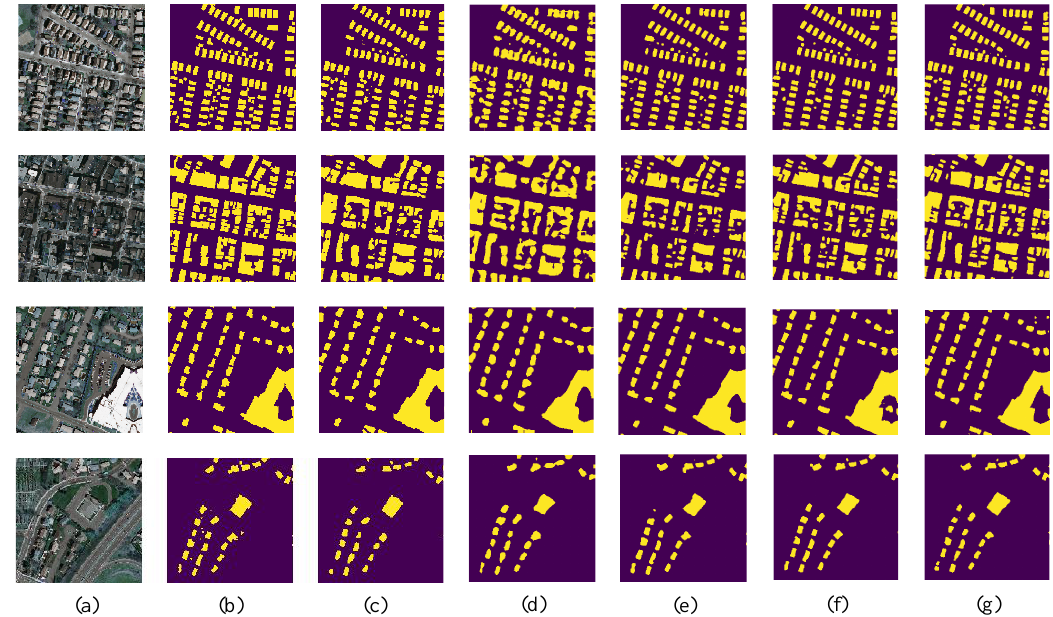
Figure 8. Predictions of some patches of different methods on the Massachusetts dataset. ( a ) Original image, ( b ) Ground truth, ( c ) GMEDN, ( d ) FCN, ( e ) SegNet, ( f ) UNetPPL, ( g )